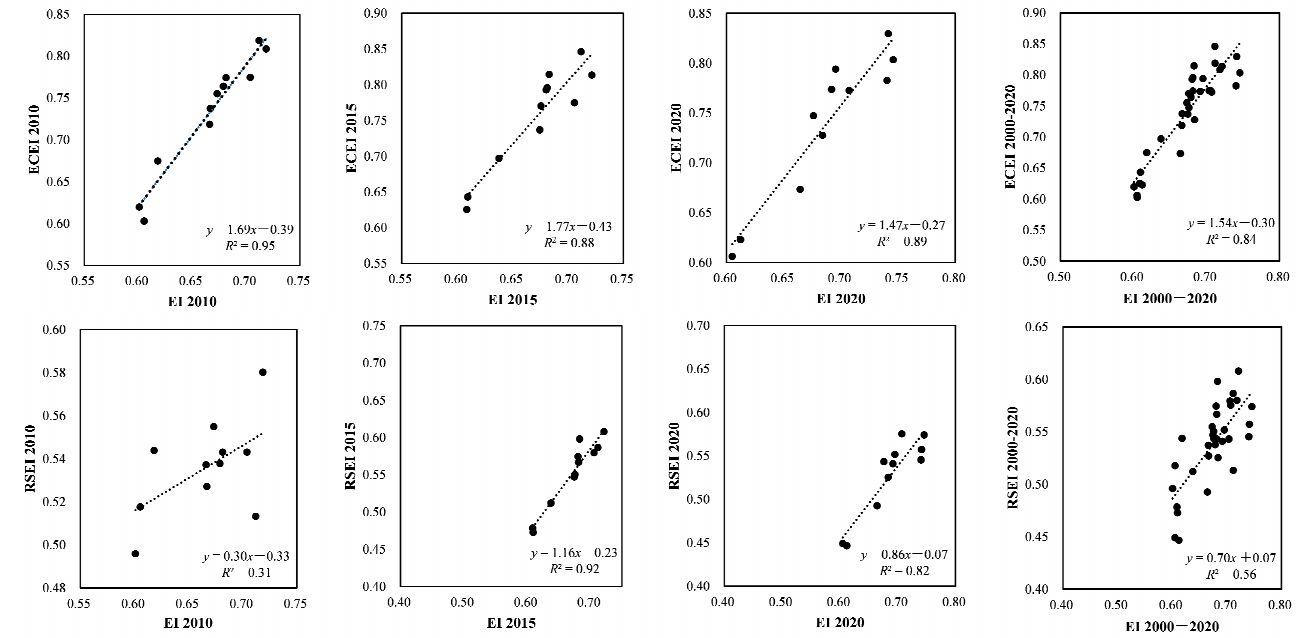
Figure 11. Scatter diagram of EI, RSEI, and ECEI from 2010 to 2020. Based on Figure 11, the coefficients of determination (R 2 ) between the EI and ECEI were 0.95 (2010), 0.88 (2015), and 0.89 (2020), with an average R 2 of 0.90. As for the R 2 between the EI and RSEI, the values of the three periods were 0.31 (2010), 0.92 (2015), and 0.82 (2020), with an average value of 0.69. It could be found that the average R 2 value between the EI and ECEI was higher than that of the EI and RSEI, indicating that the ECEI could provide more accurate and scientific EEQ results when considering land surface and season differences. In addition, the R 2 of the ECEI was more stable than the RSEI with the value ranging from 0.88 to 0.95, while the R 2 of the RSEI went from 0.31 to 0.92. In addition, the R 2 of considering all values of the three periods further validated the accuracy of the ECEI with the value of 0.84, which was higher than that of the RSEI (R 2 = 0.56). Generally, after considering land surface and season differences, the evaluation of the EEQ in typical cloudy regions was more accurate and scientific compared with the